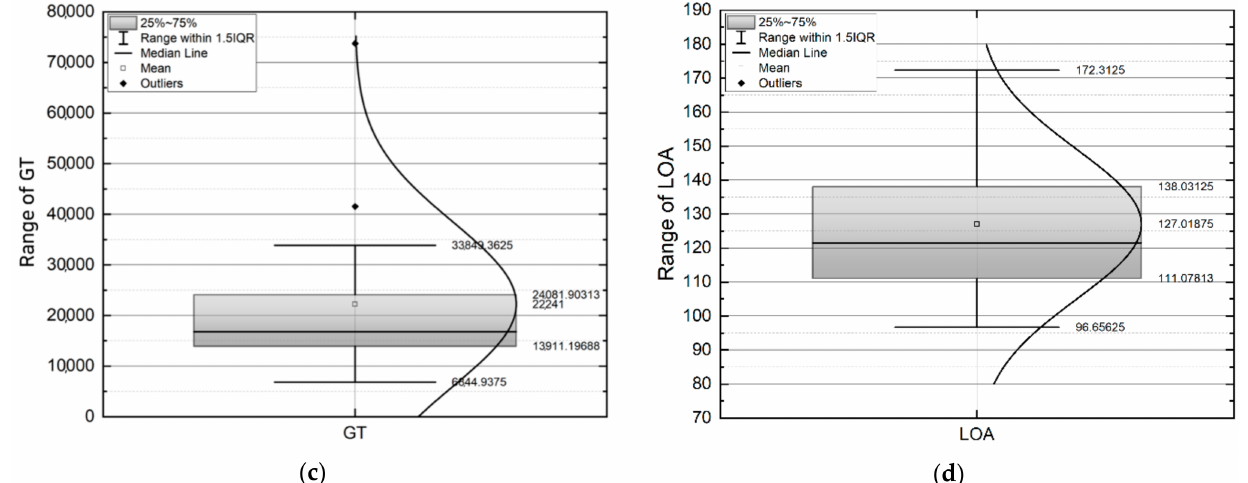
Figure 3. This figure shows a box plot and a normal distribution form to identify the statistical characteristics of the data used for analysis. ( a ) As a result of showing the COG, the mean value is about 139.5 ◦ , 25% and 75% of the data distribution are analyzed from about 118 ◦ to 164 ◦ . ( b ) As a result of representing SOG, the mean value was about 7.5 kts, 25% and 75% of the data distribution were analyzed from about 6 kts to about 9 kts. ( c ) GT of the ship by showing the results; it can be seen that the mean value is analyzed as about 22,241 tons, and the outlier appears as a value of 73,756 tons. ( d ) As a result of showing the LOA, the distribution of percentage was analyzed from about 111 to 138